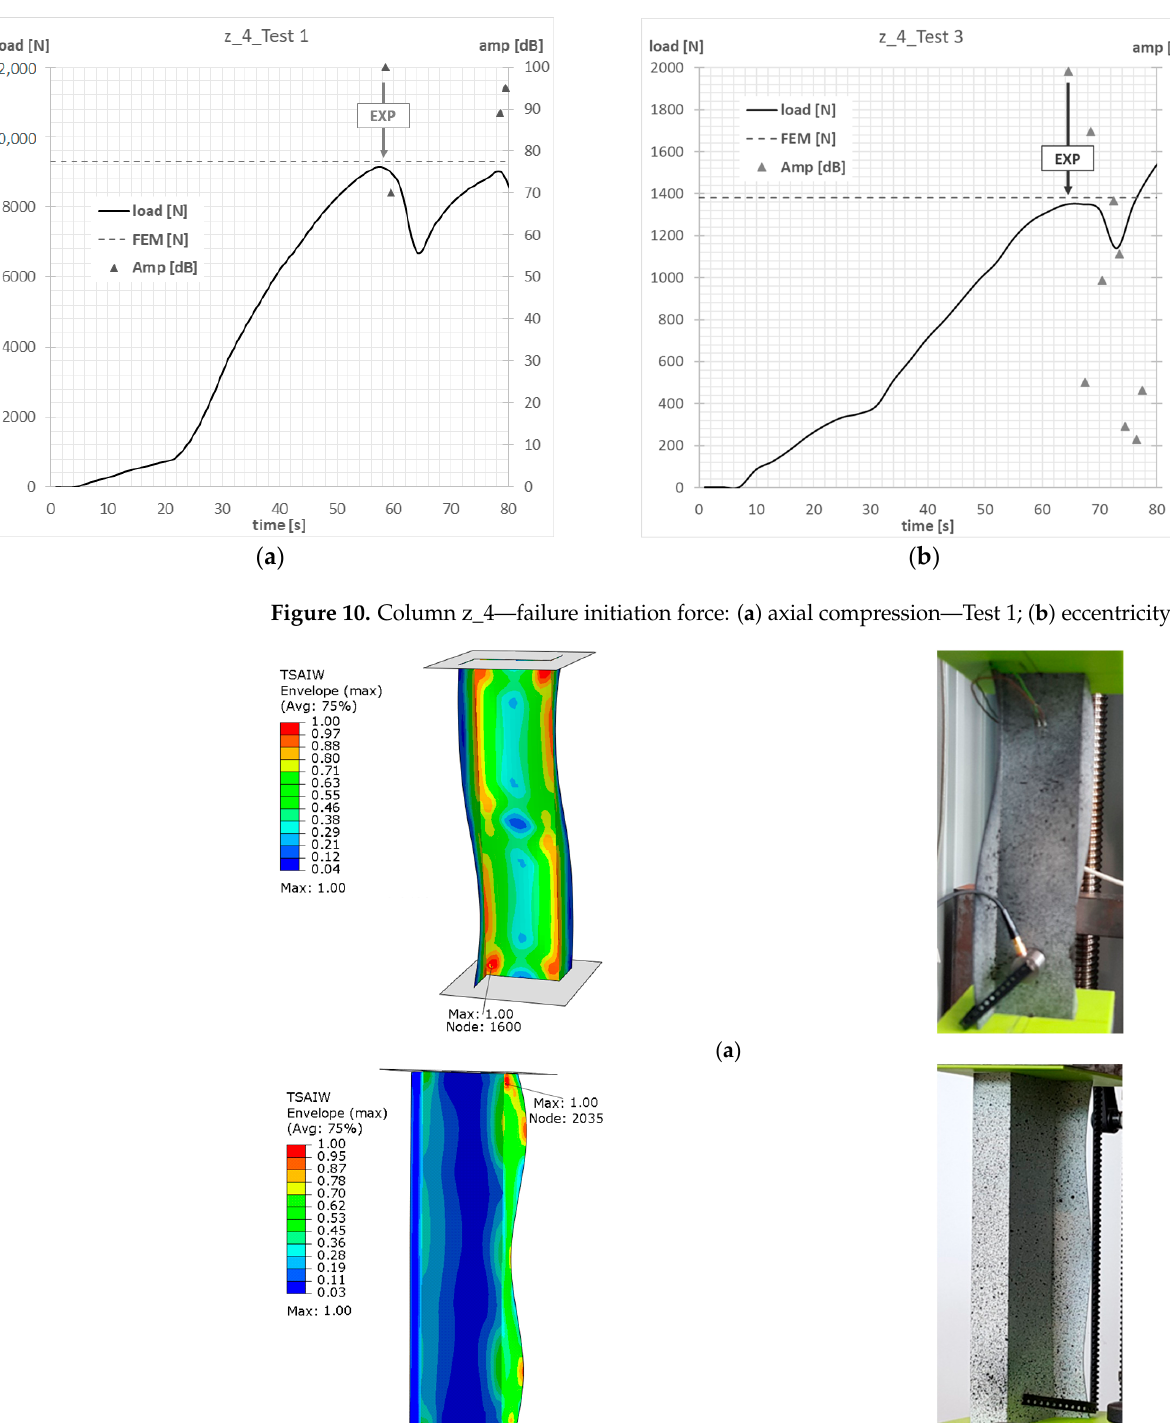
Figure 9. Column z_3—failure initiation force: ( a ) axial compression—Test 1; ( b ) eccentricity—Test 3.